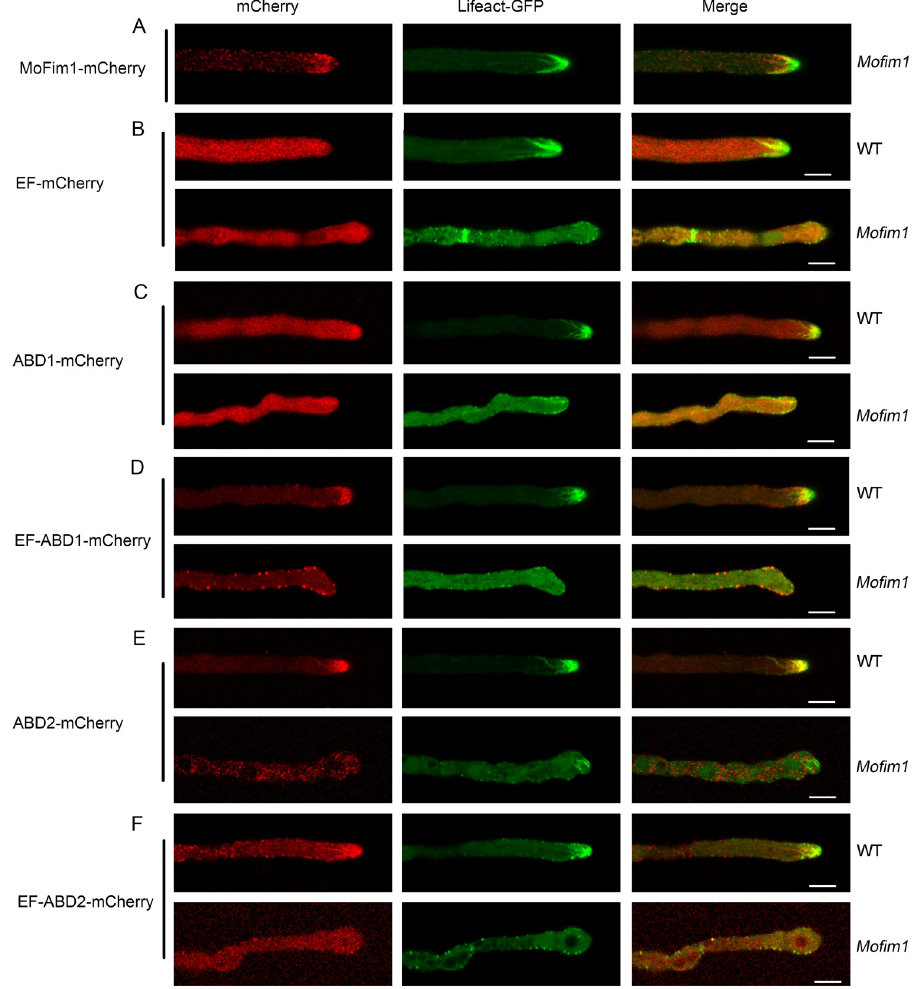
Fig 6. In vivo analysis of the characteristics of truncated MoFim1 proteins. MoFim1 and its domains fused with mCherry were expressed under the control of the native promoter of MoFim1 . Expression of MoFim1-mCherry in Lifeact-GFP-labeled Mofim1 mutant hyphae (A) . Expression of the truncated version of MoFim1 including EF (B) , ABD1 (C) , EF-ABD1 (D) , ABD2 (E) , EF-ABD2 (F) fused with mCherry in Lifeact-GFP-labeled WT and Mofim1 mutant hyphae, respectively. Bars = 5 μ